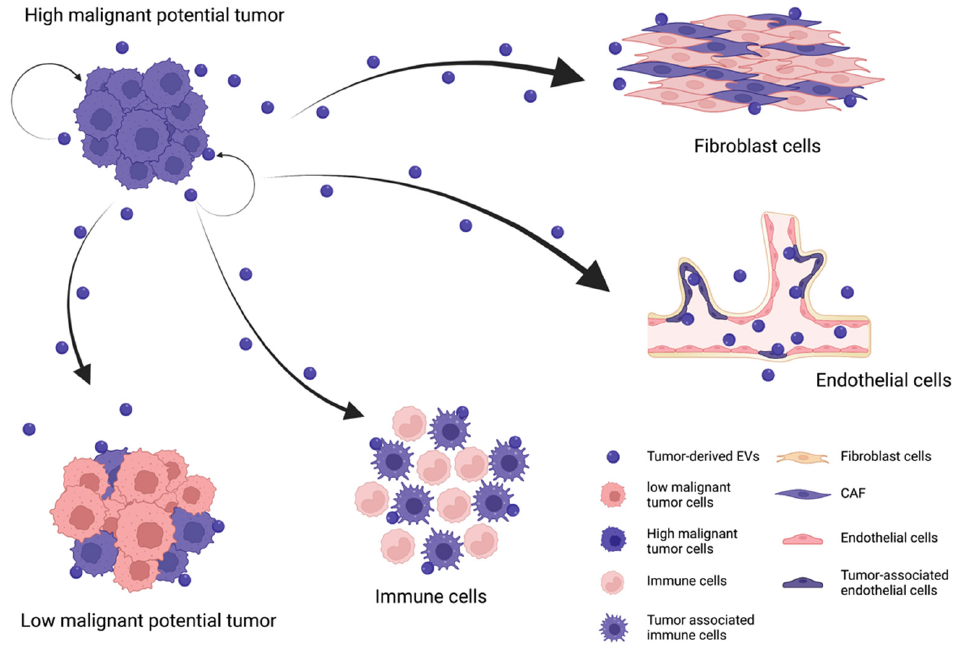
Figure 1. Tumor-derived EVs enhance the malignancy of the cells in same tumor and alter the characteristics of cells in the tumor microenvironment in an autocrine/paracrine manner. EVs regulate various signaling pathways by interacting with recipient cells or binding to receptors on their surface. The recipient cells regulated by tumor-derived EVs enhance their malignancy (changing the cell color pink to purple) and promote tumor progression.